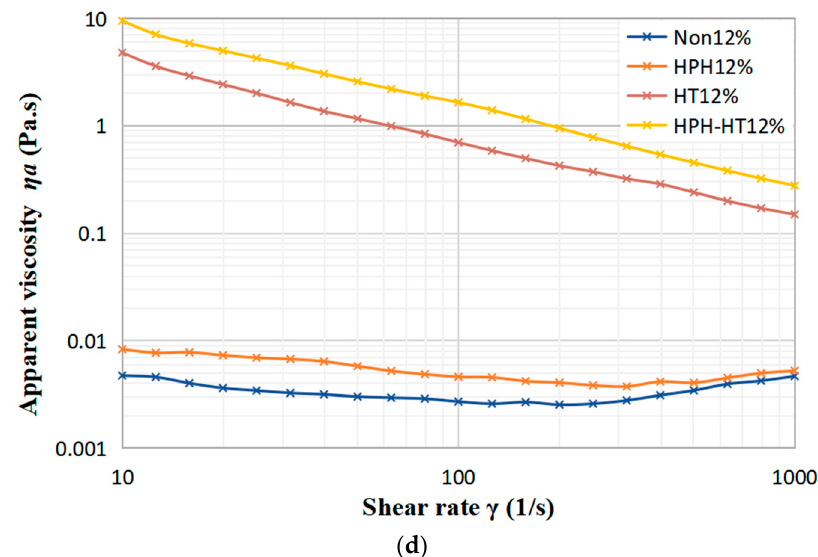
Figure 6. Variation of viscosity of DCF dispersions with shear rate for different concentration ( a ), and different treatment of concentration 4% ( b ), 8% ( c ), and 12% ( d ).